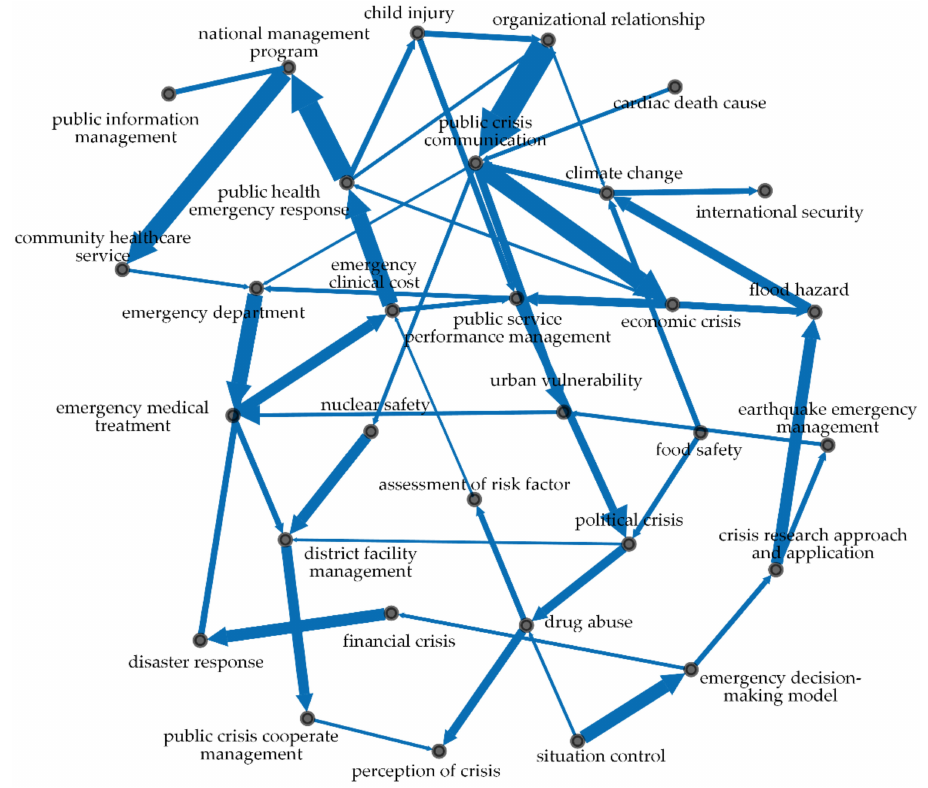
Figure 8. Transfer network of the